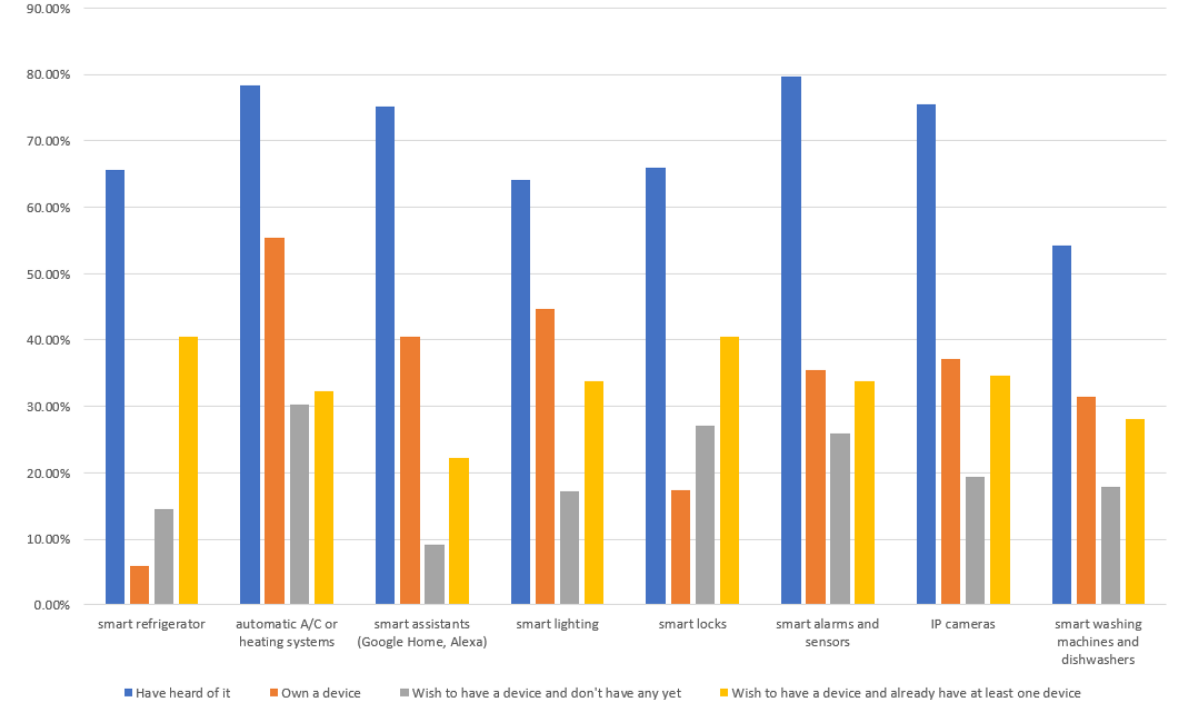
Figure 2. Ownership and familiarity with IoT devices.